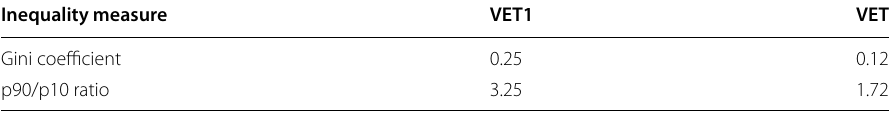
Source: BIBB/BAuA Employment Survey 2018 Population: German